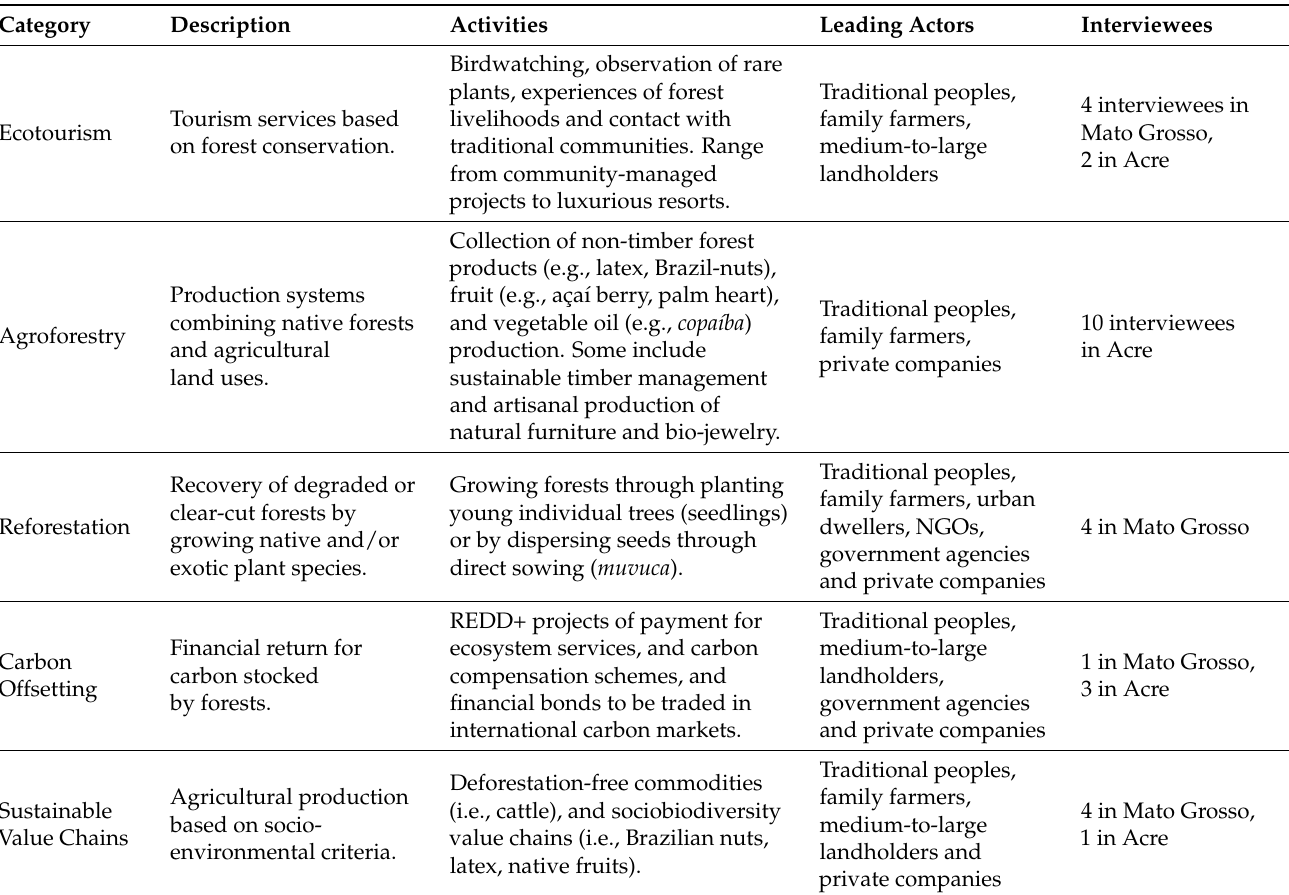
Table 2. Visited initiatives in the Brazilian states of Acre and Mato Grosso during